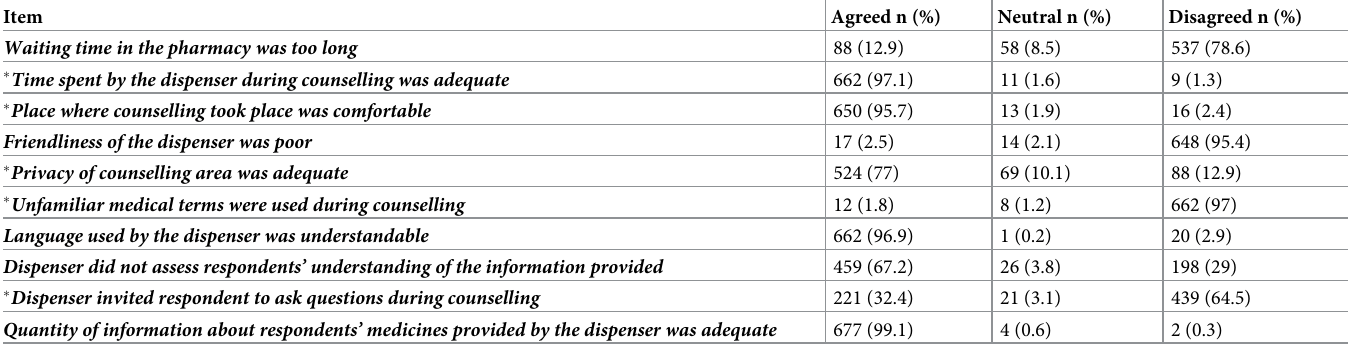
Table 2. Respondents experiences during medication counselling (n =